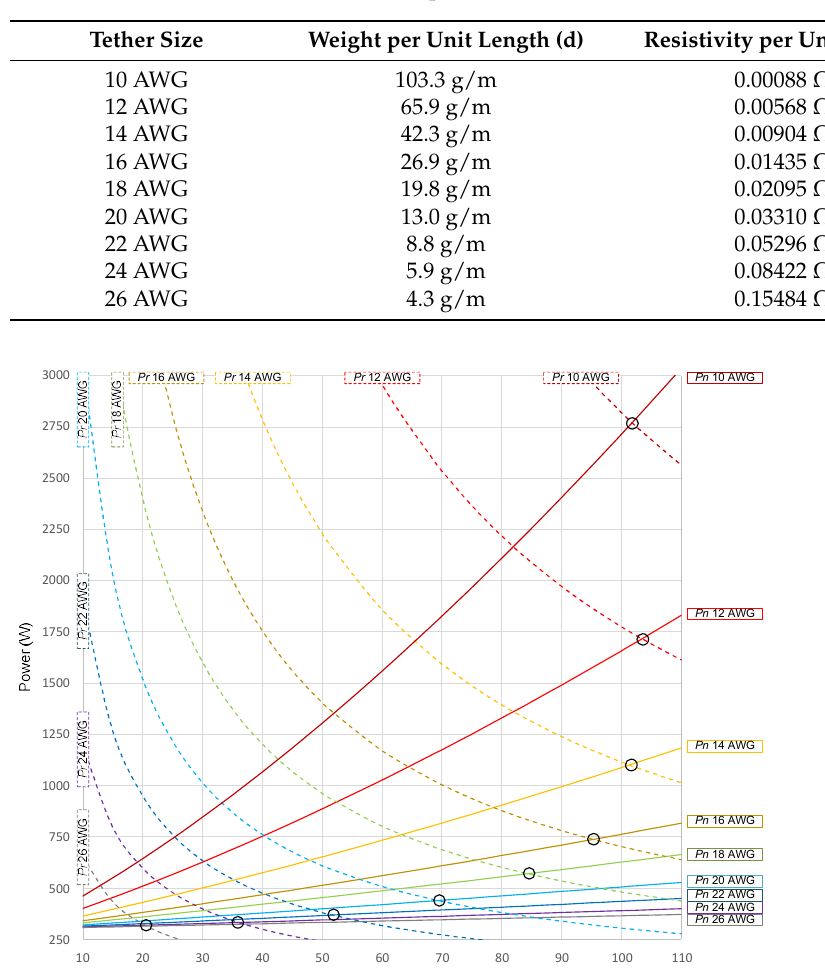
Figure 4. The solid lines indicate the needed power, P n , versus the tether’s length. The dash lines indicate the received power, P r , versus the tether’s length. For a certain tether size, the junction of the solid line and the dash line indicates the maximum altitude and its corresponding power.